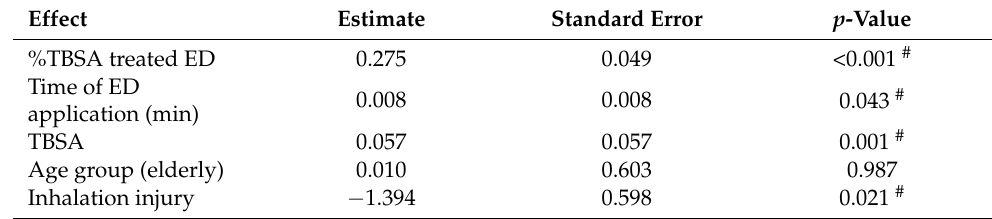
Table 4. Linear regression predicting the burn size debrided enzymatically versus surgically (n =